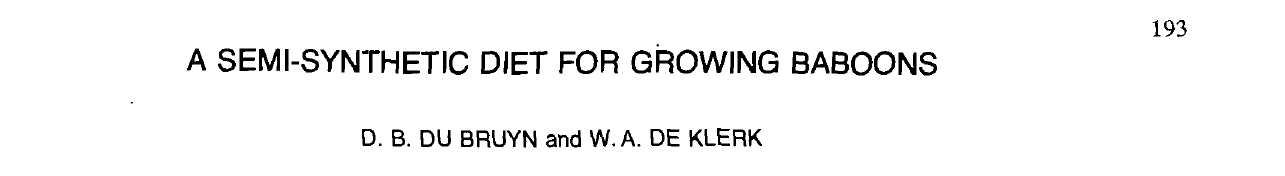
Table 1: COMPOSITION OF A SEMI-SYNTHETIC DIET WHICH HAS PROVED SUCCESSFUL IN THE FEEDING OF YOUNG BABOONS IN